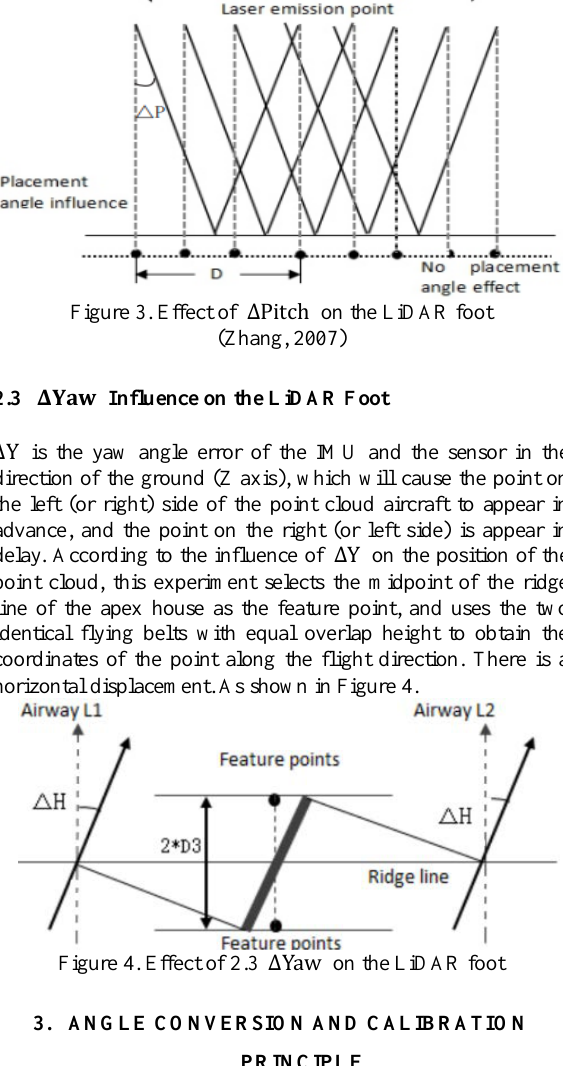
on the LiDAR foot ∆ Yaw